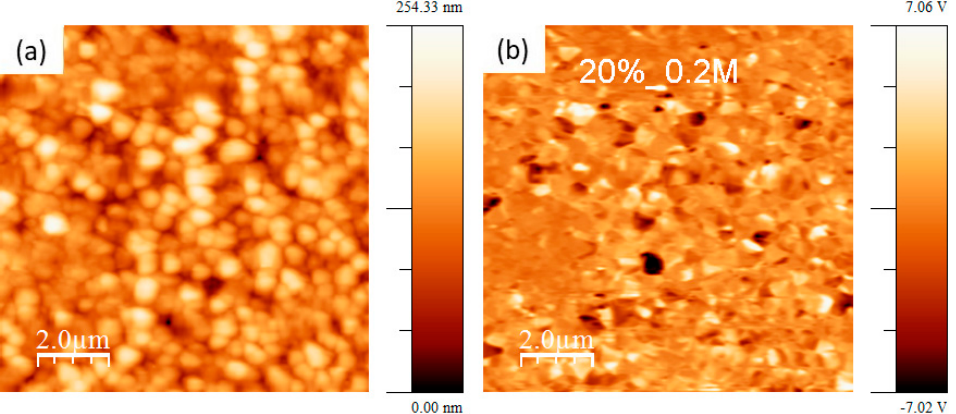
Figure 7. Topography ( a ) and out-of-plane piezo-force response image ( b ) of KNN thin films with 20% alkali excess and 0.2 M concentration deposited on platinized Al 2 O 3 .